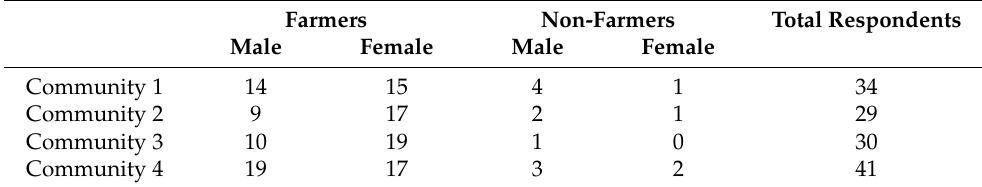
Table 1. Demographic information of study communities ( n = 134 total respondents). Farmers Non-Farmers Total